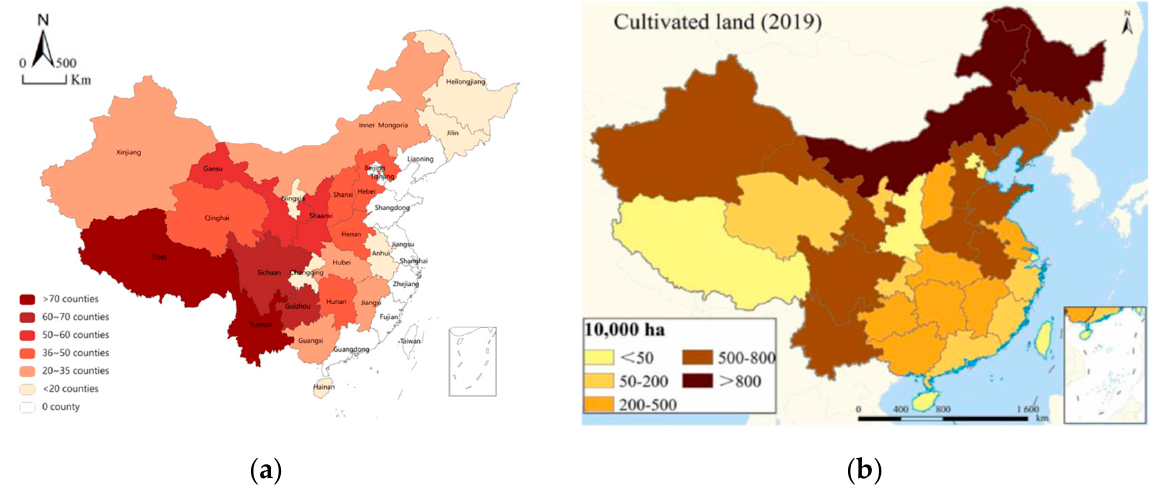
Figure 1. ( a ) Distribution of national poverty-stricken counties in China; ( b ) Distribution of arable land in China (note: this figure is from the article produced by Zhou Y, Zhong Z, Cheng G).